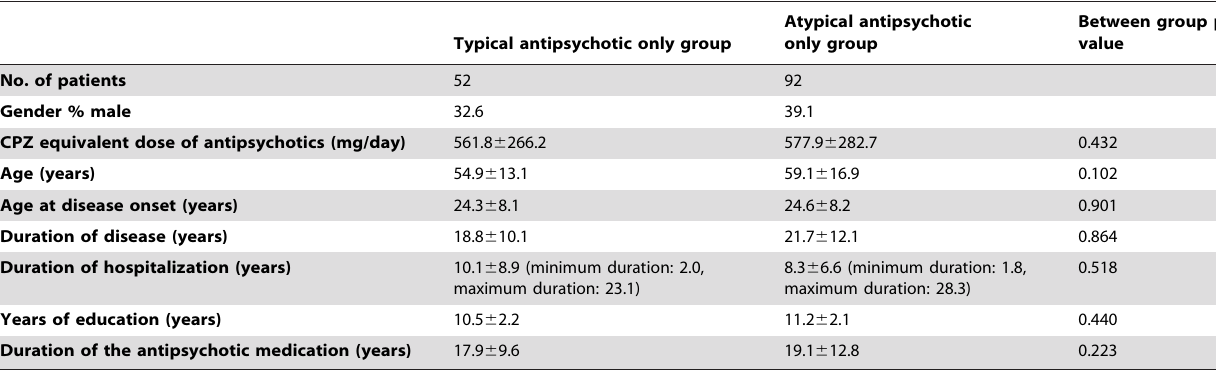
Table 1. Patients’ characteristics (mean 6